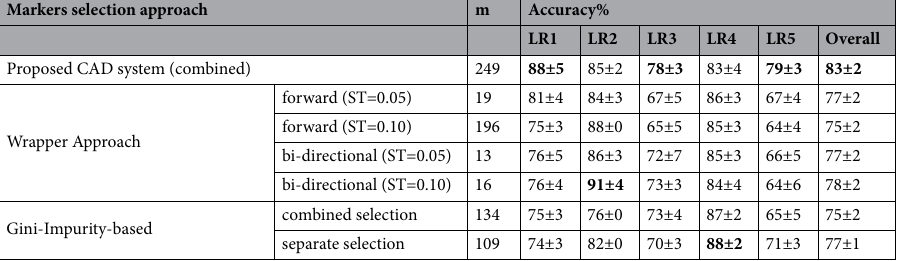
Table 7. Comparison of the two-stage diagnostic performance using the developed CAD system (combined markers) with the performance of six different features/markers selection scenarios. Let m and ST denote the number of the used markers and significance threshold, respectively.